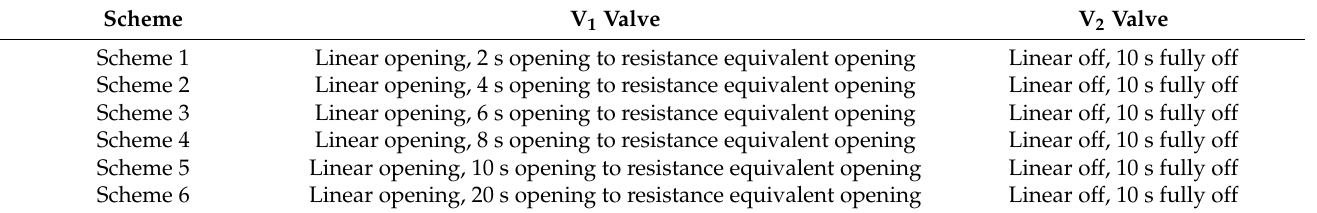
Table 7. Valve co-operation